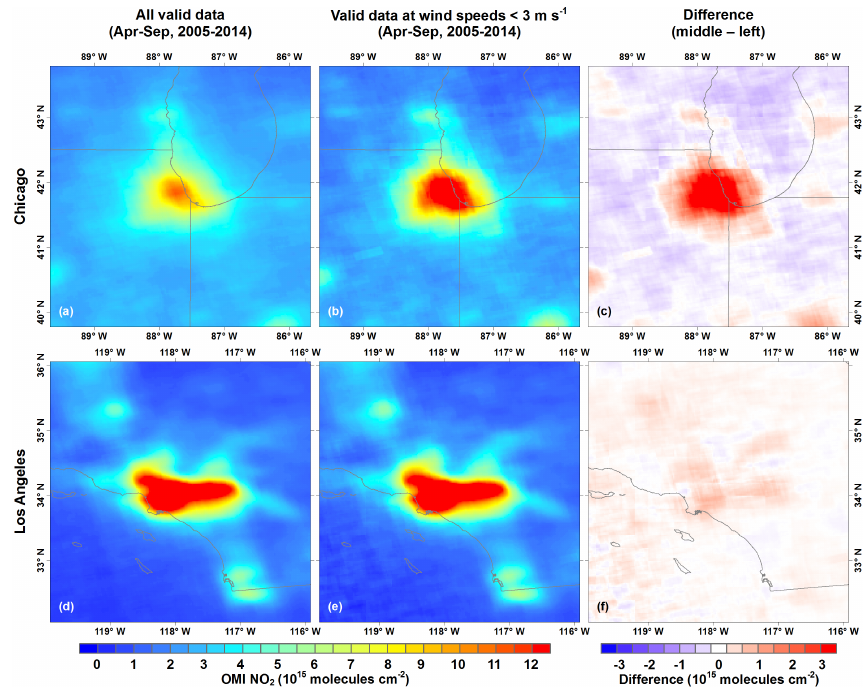
Figure 4. Average summer half-year (i.e., April–September) OMI NO 2 TVCDs over (a, b) Chicago and (d, e) Los Angeles during 2005– 2014: (a, d) all valid data were used, (b, e) only valid data with wind speeds <3ms − 1 were used, and (c, f) the difference between the middle and the left